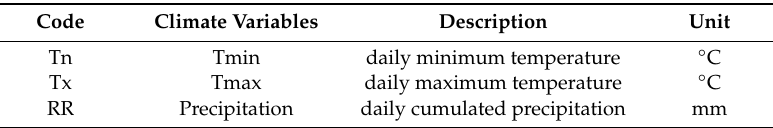
Table 2. Selected climate variables.